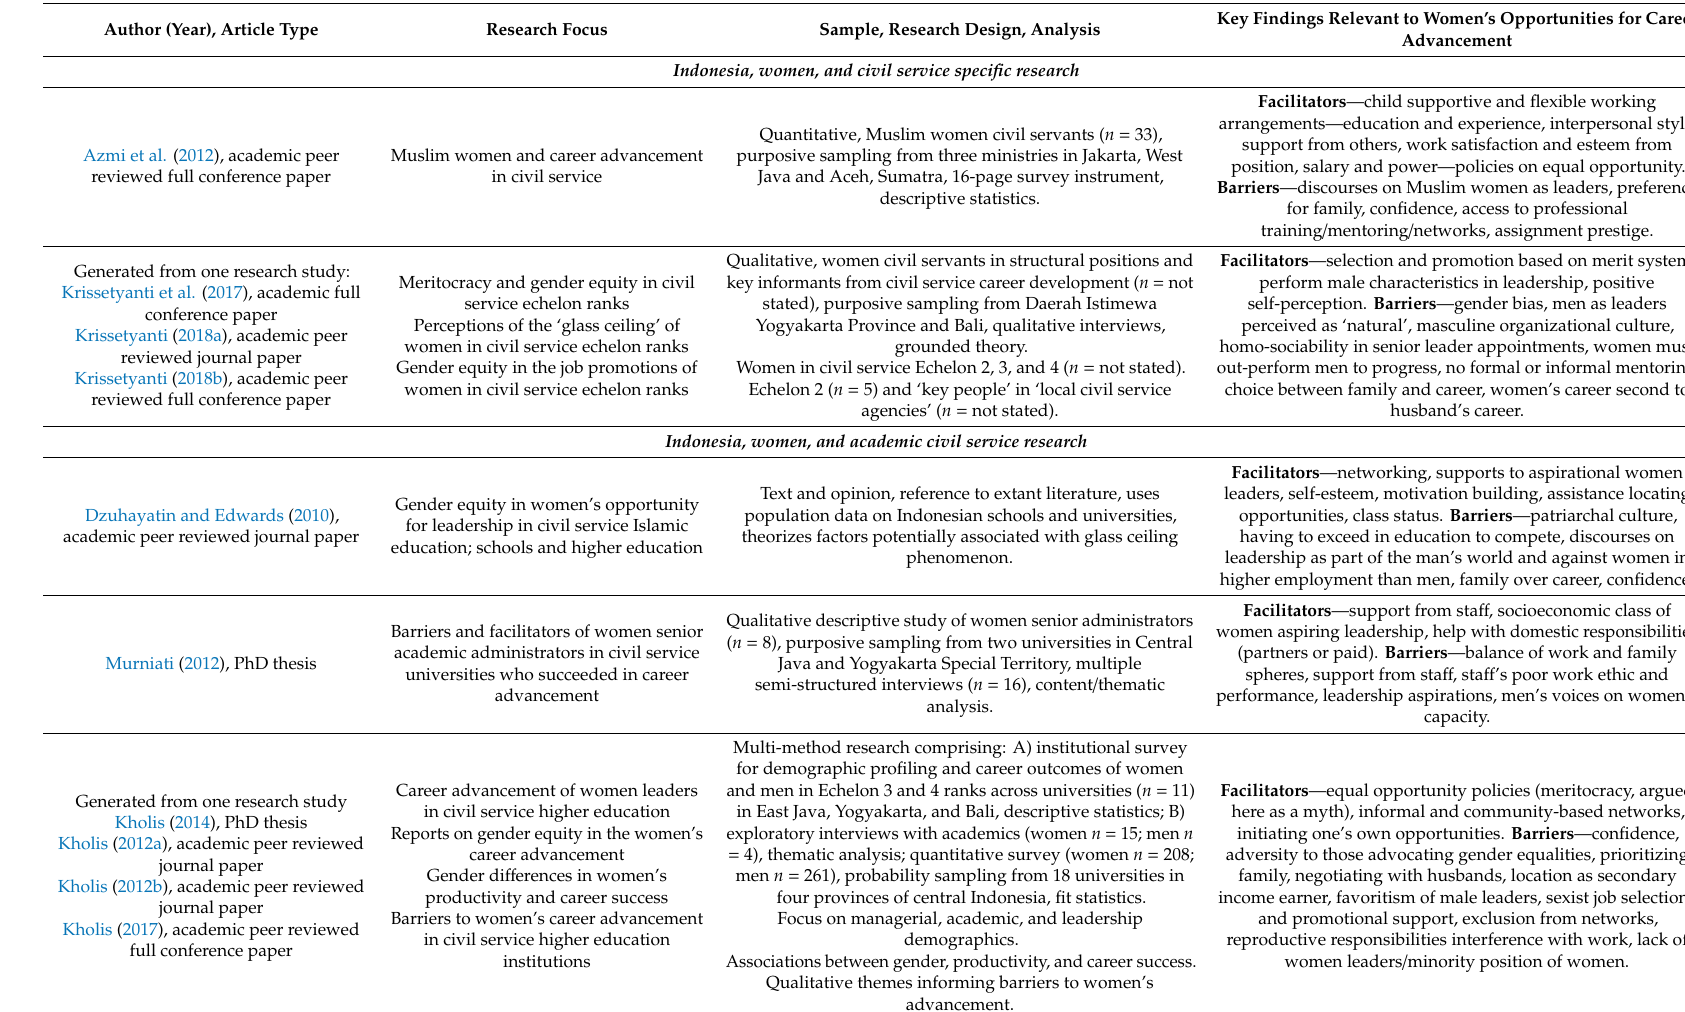
Table 1. Overview of research studies and articles included, research design and